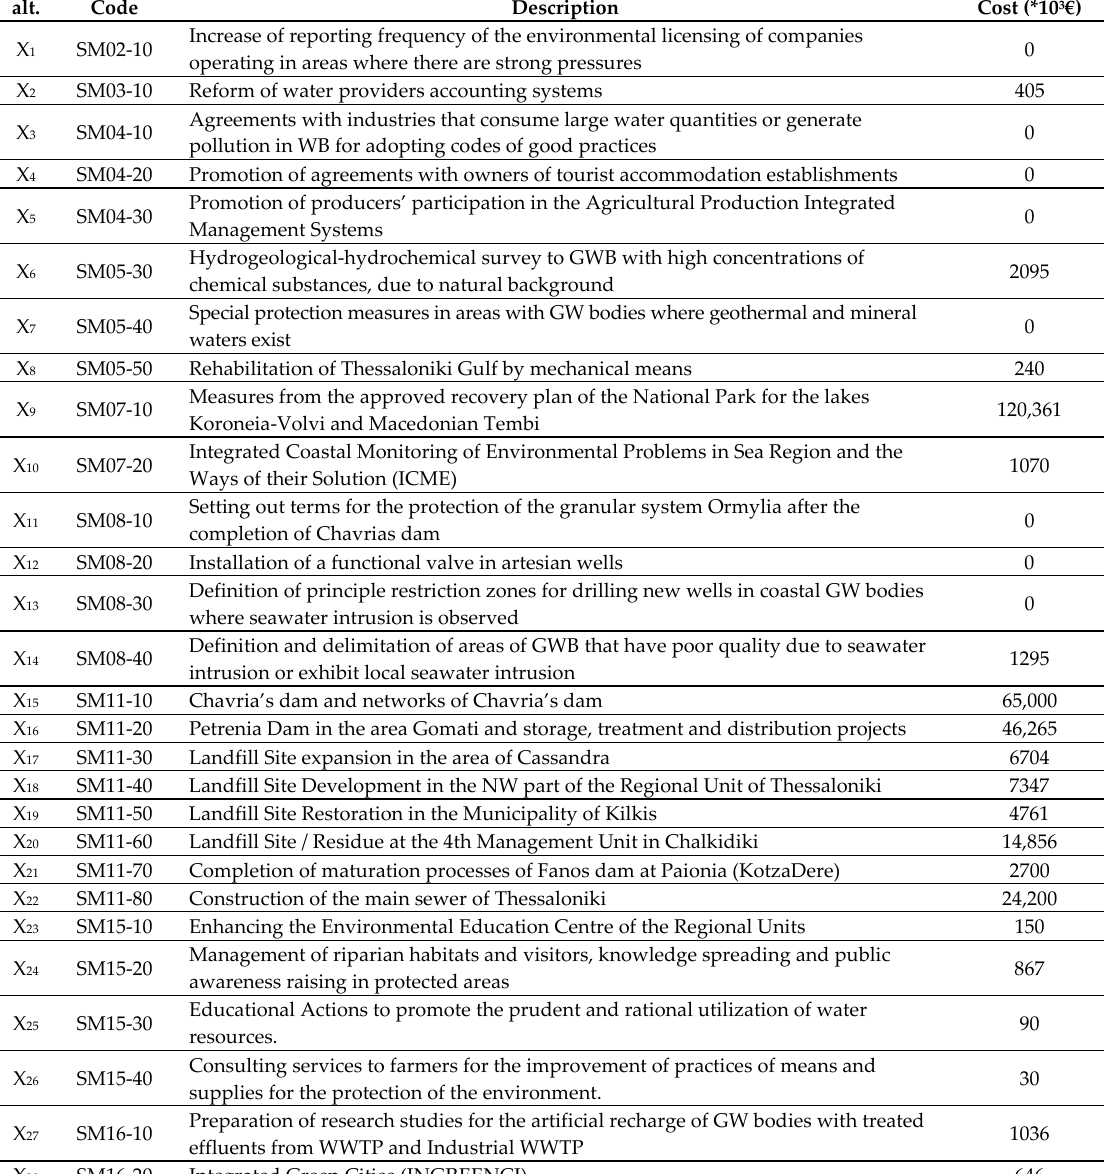
Table 1. List of supplementary measures of the RBMP of Central Macedonia River Basin District.